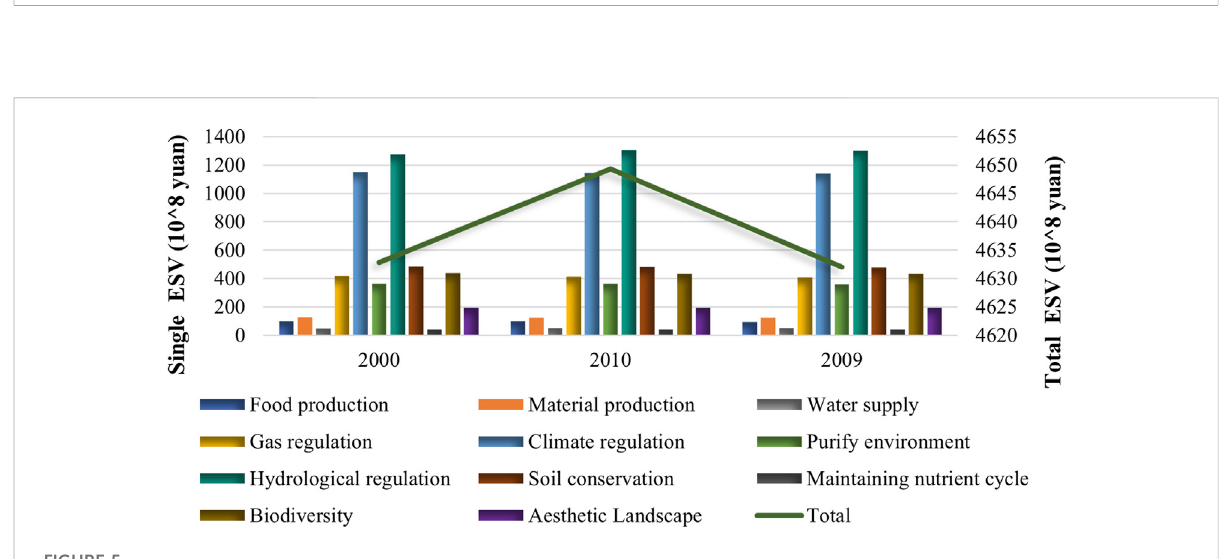
FIGURE 5 The single service value and the total value of ecosystem in YRDEB in 2000, 2010,